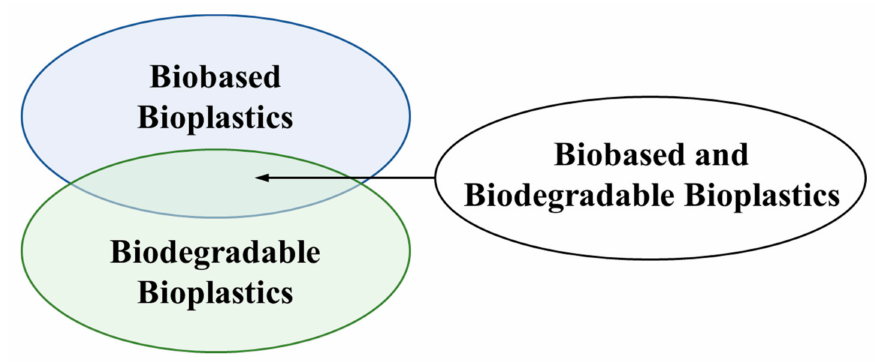
Figure 10. Classification of plastics based on sources and biodegradability.